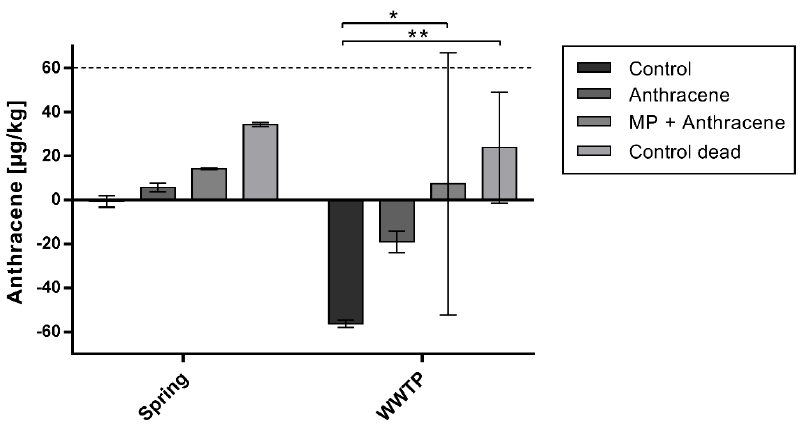
Figure 6. Anthracene concentrations detected in the sediment after two weeks of incubation, minus the respective ambient background concentration of anthracene detected in the environmental sample. The spiked concentration of anthracene is displayed in the dashed line (60 μ g/kg). Significant differences (two ‐ way ANOVA; * p < 0.05, ** p < 0.01) were detected between the control group and the treatment with microplastic (MP) + Anthracene and the dead control. Even though high amounts of sodium azide were added to the dead control, anthracene was still degraded. Different treatments at the spring site were not significant using the two ‐ way ANOVA due to the high variance at the wastewater treatment plant (WWTP).